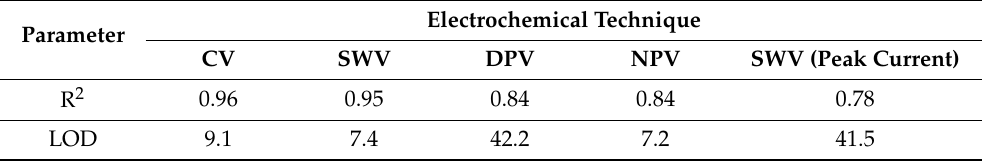
Table 2. The summary of LODs based on the employed electrochemical techniques 0–20 ng/µL range of the MCF 7 exosomal RNAs.